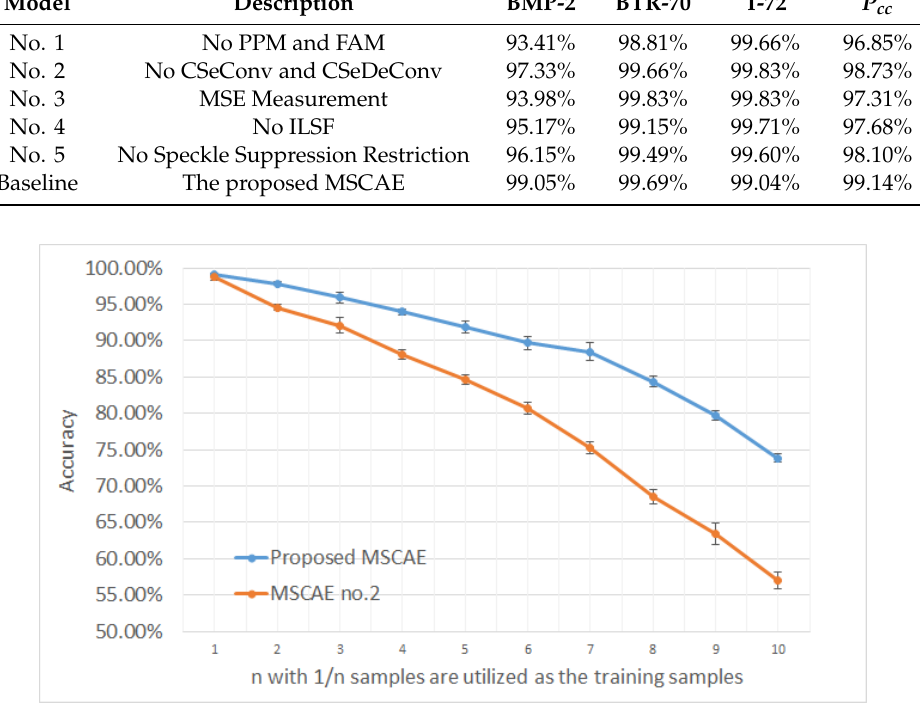
Figure 11. Validation of the proposed model with a small dataset when 1/ n samples were randomly selected to train the model.